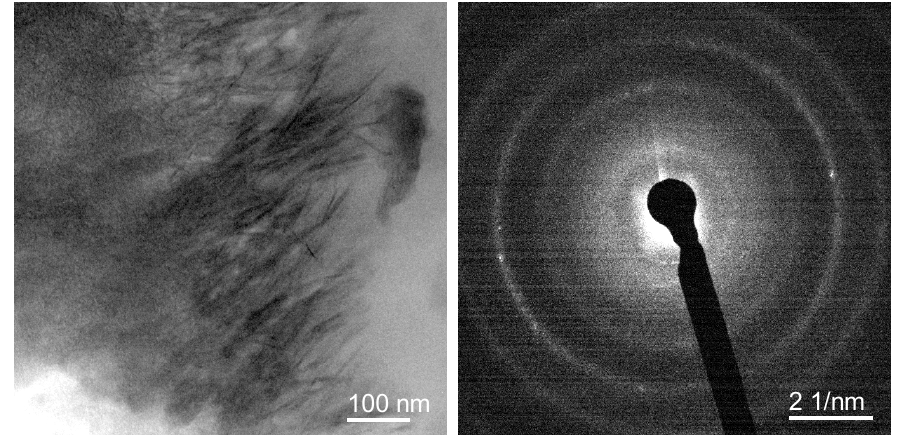
Figure A3. Bright field (BF) TEM micrograph of the outer region of HydBo layer in EP2 medium (left) diffraction pattern showing crystallinity of region in on the left (right).